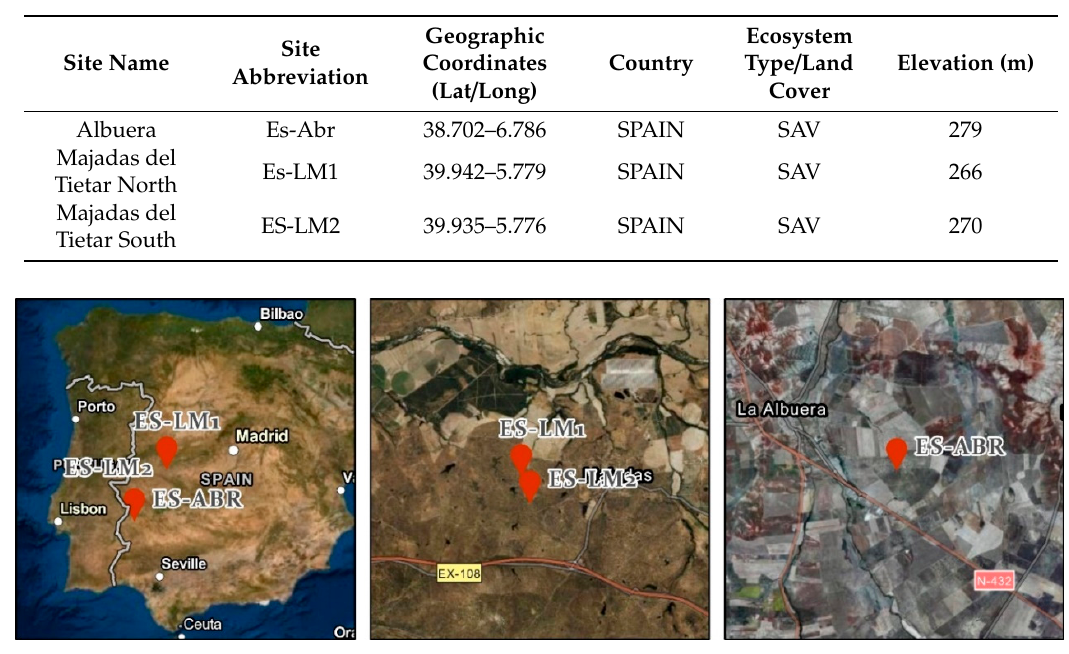
Figure 1. Geographical locations of study sites in Spain (background image source: ArcGIS Online).